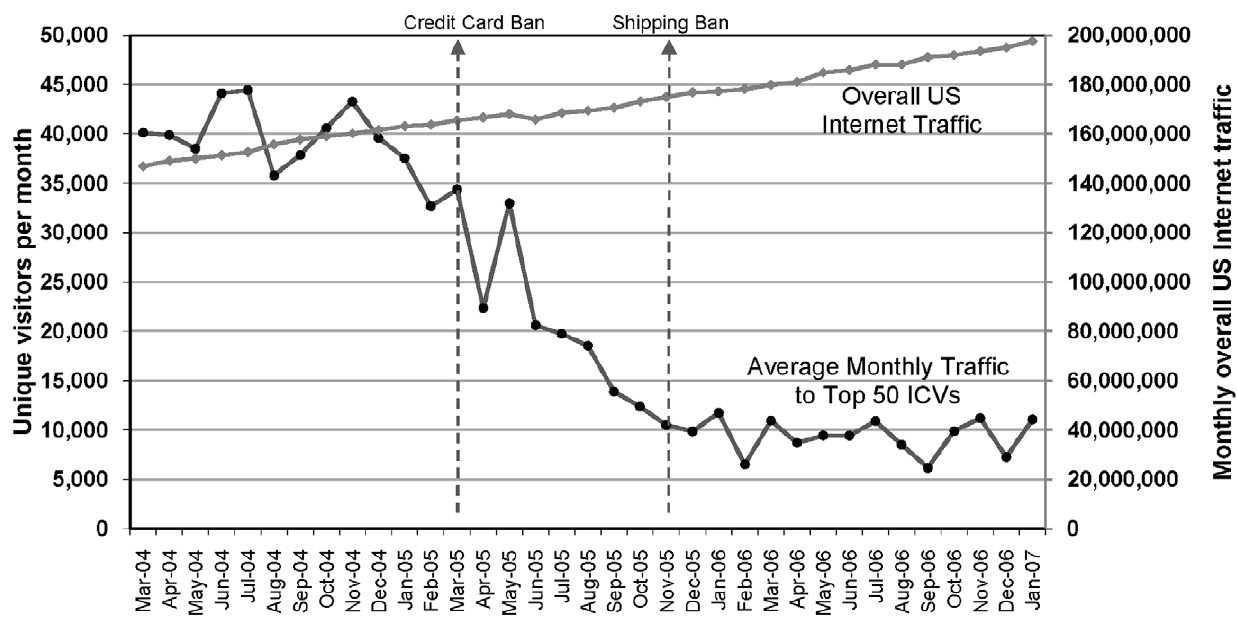
Figure 3. Visitor traffic 2004–2007 for 50 most popular Internet cigarette vendor websites. Average number of unique visitors from March 2004 to January 2007 for the 50 Internet cigarette vendor websites which were most popular in January 2005. Not all of the websites which were most popular in January 2005 were in business in March 2004. Sites were counted as missing data until they started receiving traffic.